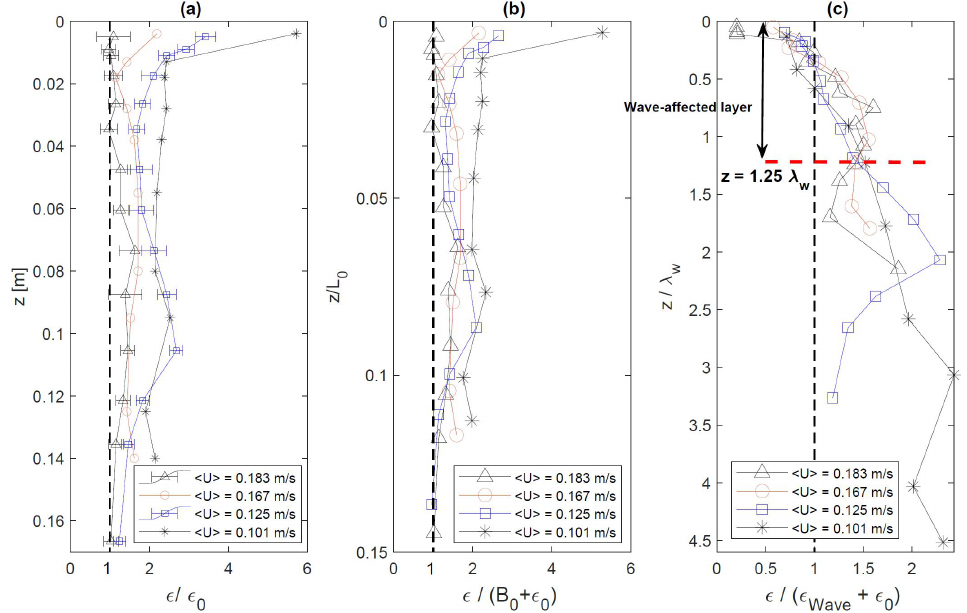
Figure 5. (cid:101) vertical profile is shown for the mean flow velocity range of 0.101 m/s< < U > < 0.183 m/s. The data were measured at a depth of z = 0.005 m to 0.17 m at the downstream distance of x / M = 37. ( a ) (cid:101) is normalized by the background, or internal, turbulence kinetic energy dissipation rate generated by the grid, (cid:101) 0 . The associated error bars are depicted for < U > = 0.125 m/s and 0.183 m/s. ( b ) (cid:101) is normalized by the summation of surface buoyancy flux, B 0 , and (cid:101) 0 . ( c ) The (cid:101) is normalized by the summation of wave-generated turbulent kinetic energy dissipation rate, (cid:101) wave , and (cid:101) 0 . The wave-affected layer is presented with the dashed red